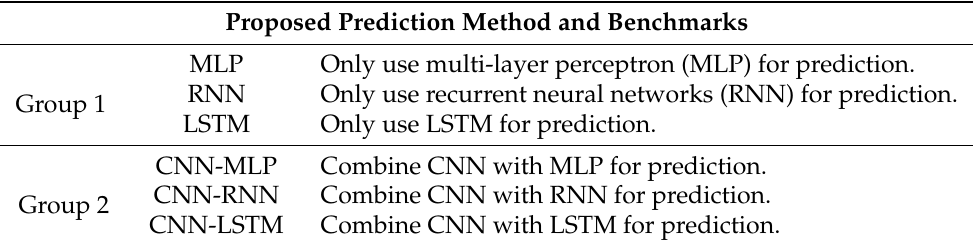
Table 2. Proposed prediction method and the setup of